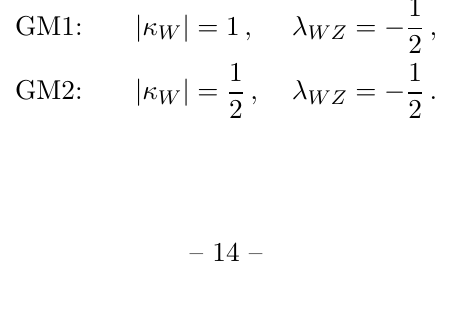
0 : 8 ; +0 : 3). Left: discriminating the (BP2, BP3) (cid:0) (cid:20) W - (cid:21) WZ plane that satis(cid:12)es Z 1 : 64, j j (cid:20)